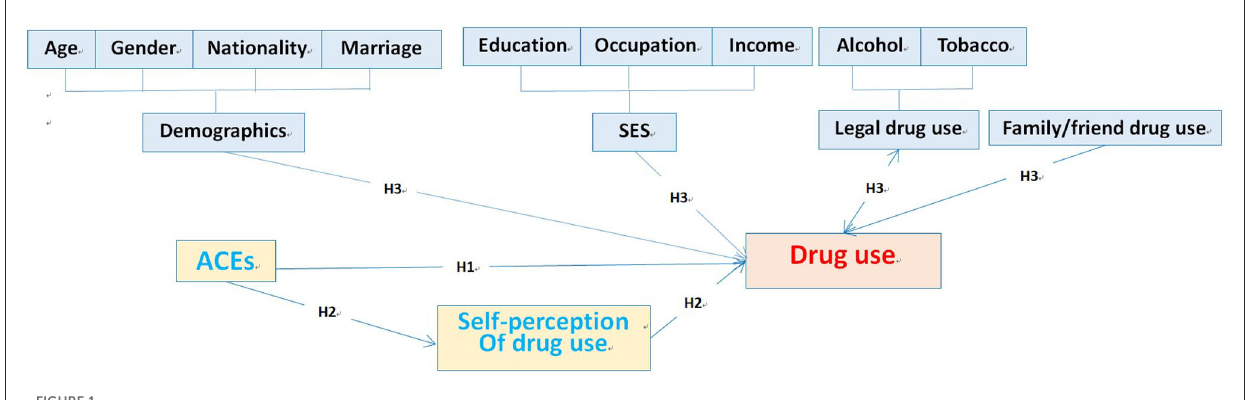
FIGURE1 Hypotheses of the study.